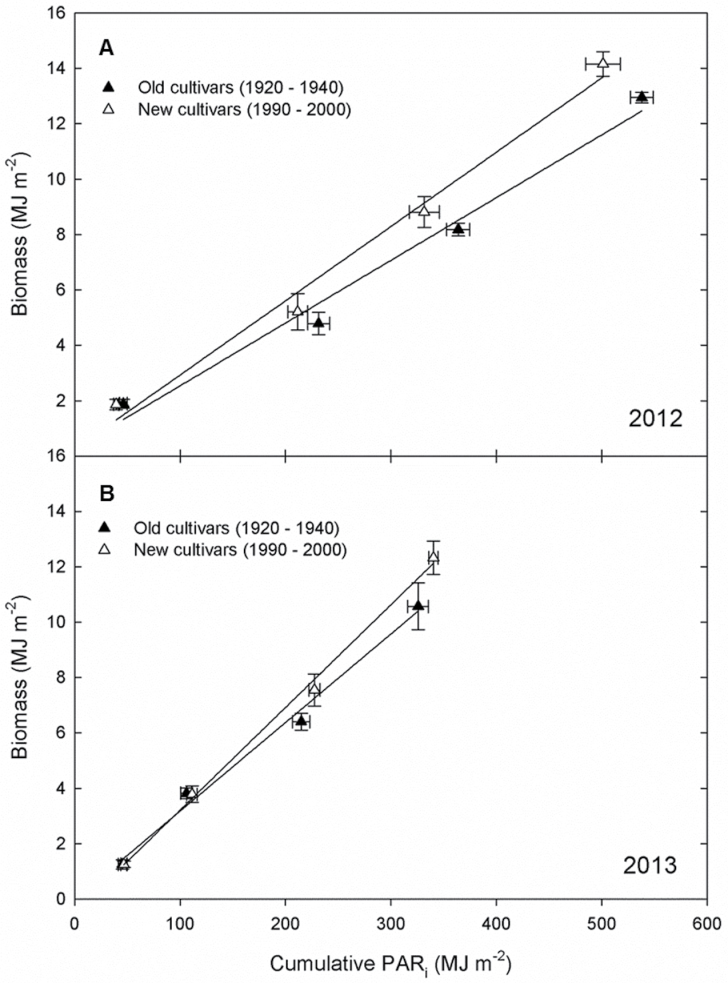
Accumulated aboveground biomass versus cumulative PARi in 2012 (A) and 2013 (B). Lines represent least-squared regression between dry biomass versus cumulative PARi. The slope of each line (m) is εc. Each point represents the biomass and cumulative PARi for the five oldest cultivars and the five most recently released cultivars.